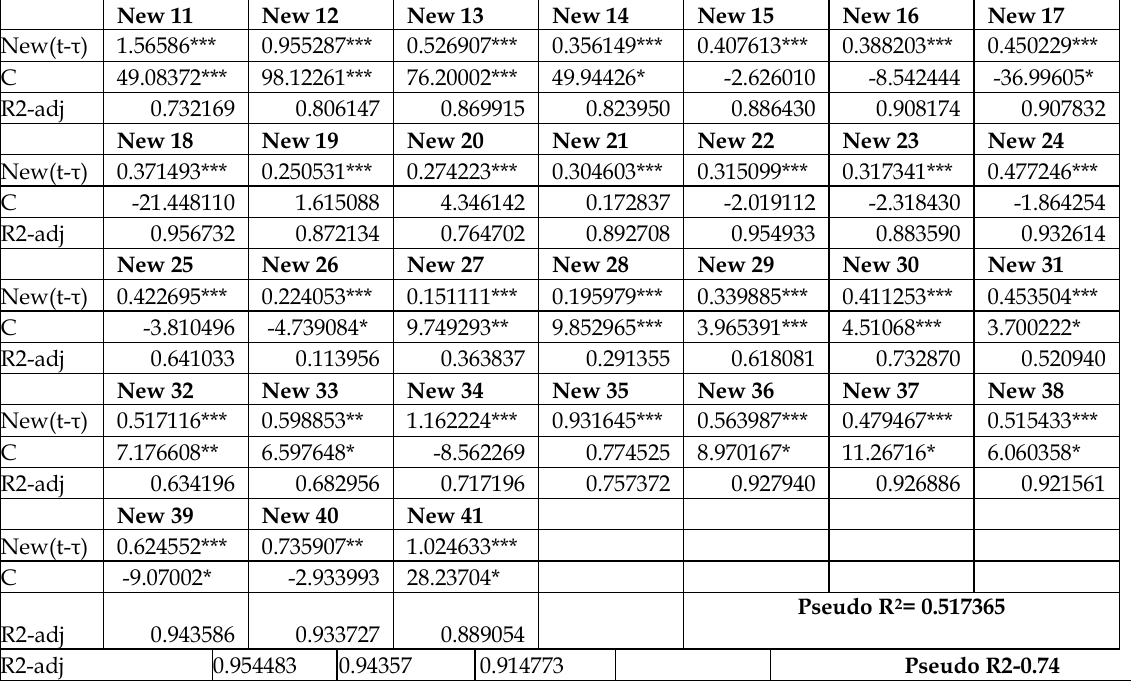
Parameters of base model, which include new cases only by weeks (Equation